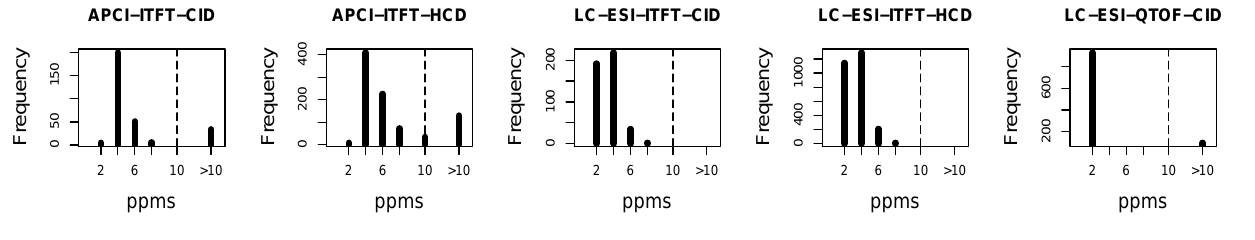
Figure 5. Histogram of the difference between derived mass and exact mass, measured in ppm, intercepted at 10. The difference less than 10 ppm accounts for 88%, 85%, 100%, 100%, 90% of the difference between derived mass and exact mass for five datasets